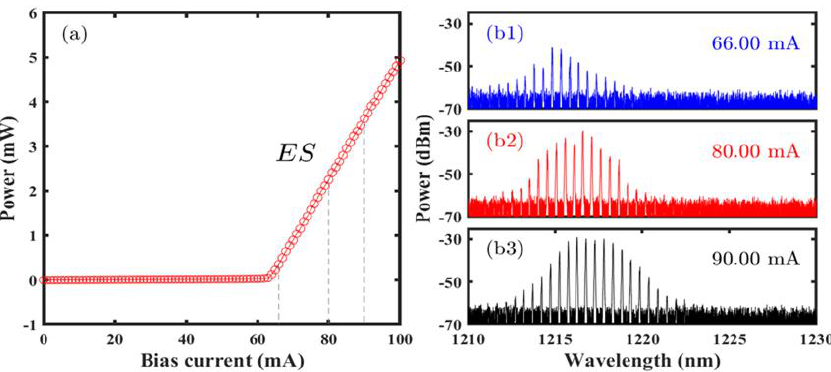
Figure 2. ( a ) Power-current ( P−I ) curve of free-running ESQDL and ( b ) optical spectra for the ESQDL biased at ( b1 ) 66.00 mA, ( b2 ) 80.00 mA and ( b3 ) 90.00 mA, respectively.